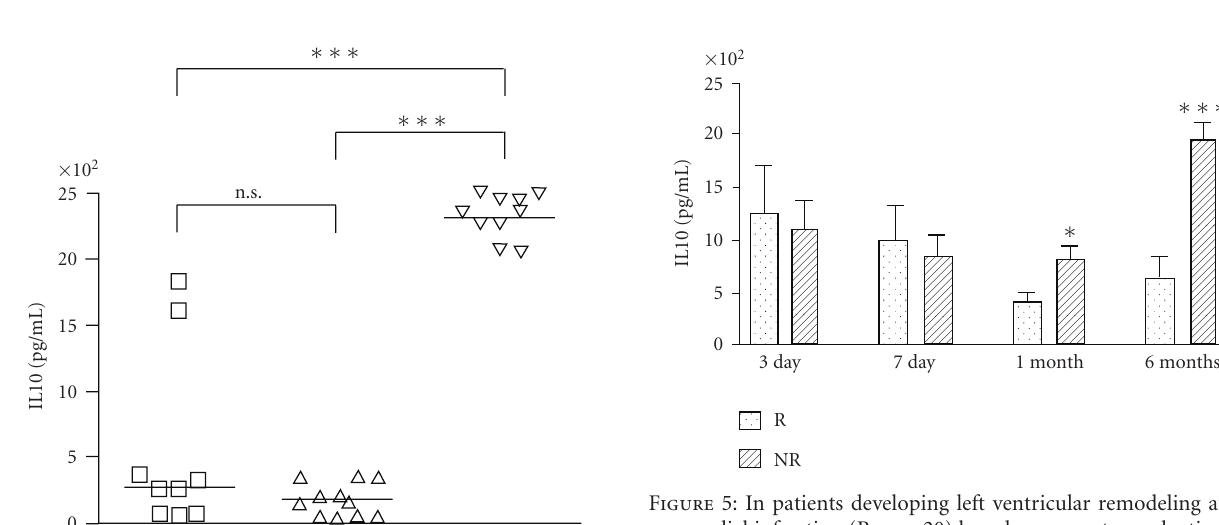
Figure 3: Both in patients developing left ventricular remodeling after myocardial infarction ( n = 20) and in patients not developing left ventricular remodeling ( n = 20) lymphomonocyte production of TNF- α in response to LPS was not di ff erent amongst the di ff erent timepoints evaluated.